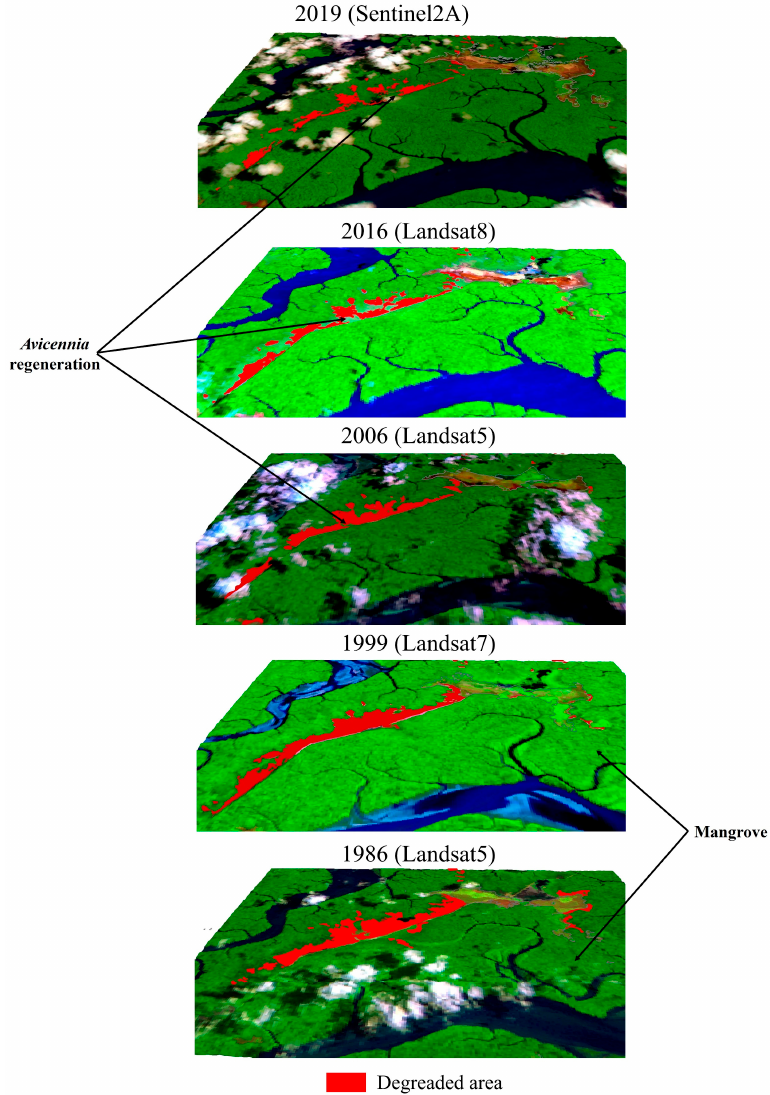
Figure 7. Spatial-temporal changes of the degraded mangrove area using mid-resolution imagery from 1986 to 2019.